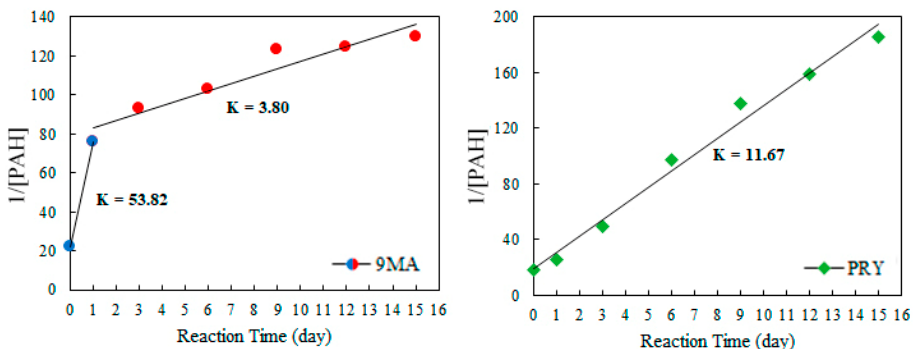
Figure 3. Pseudo second order rate constants for WLP (with 0% of H 2 O 2 ) degradation reaction of 9-methylanthracene and pyrene.